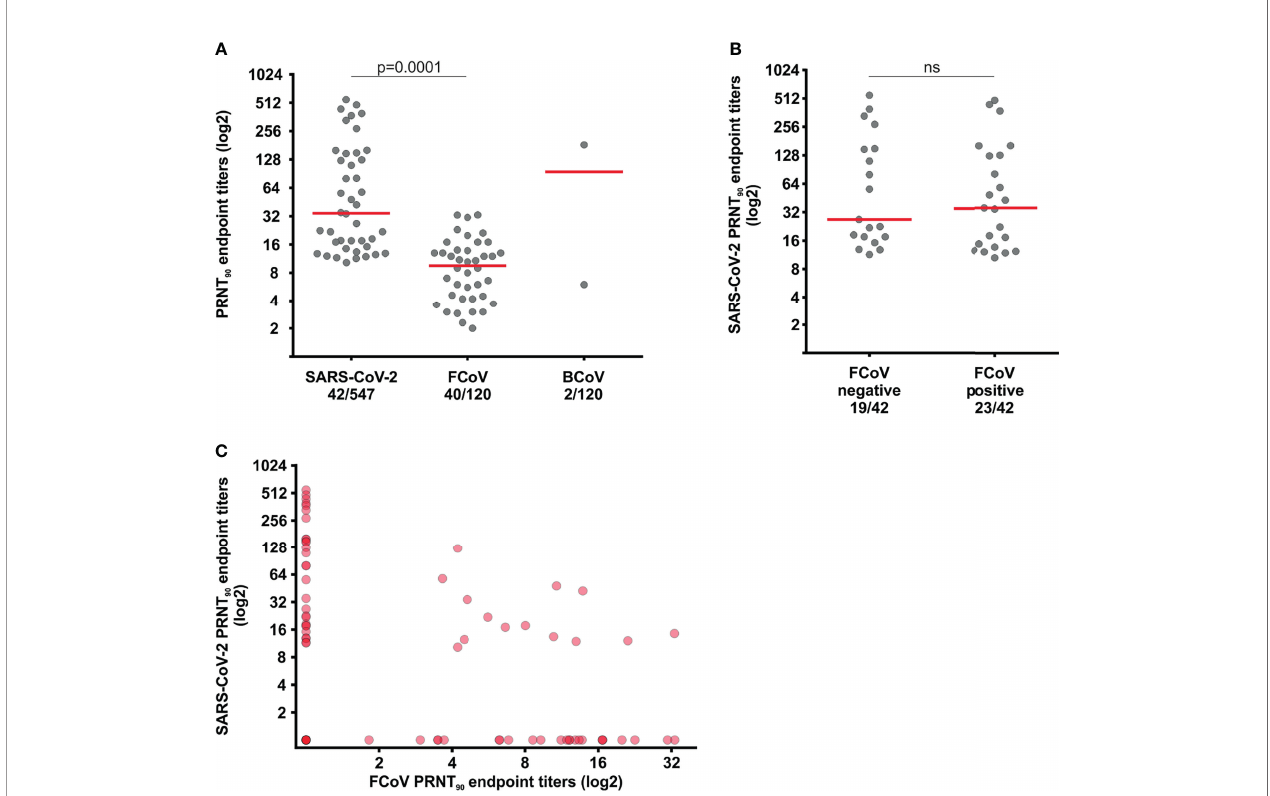
FIGURE 3 | Neutralizing antibodies against SARS-CoV-2 and enzootic coronaviruses. (A) Comparison of the reciprocal FCoV, BCoV and SARS-CoV-2 PRNT 90 endpoint titers in cat sera. (B) Comparison of SARS-CoV-2 and FCoV PRNT 90 endpoint titers. (C) Reciprocal SARS-CoV-2 PRNT 90 endpoint titers among FCoV-positive and -negative sera. Statistical signi fi cance was inferred using the Mann-Whitney test in (A) and (B) . The red bars indicate medians; ns, not statistically signi fi